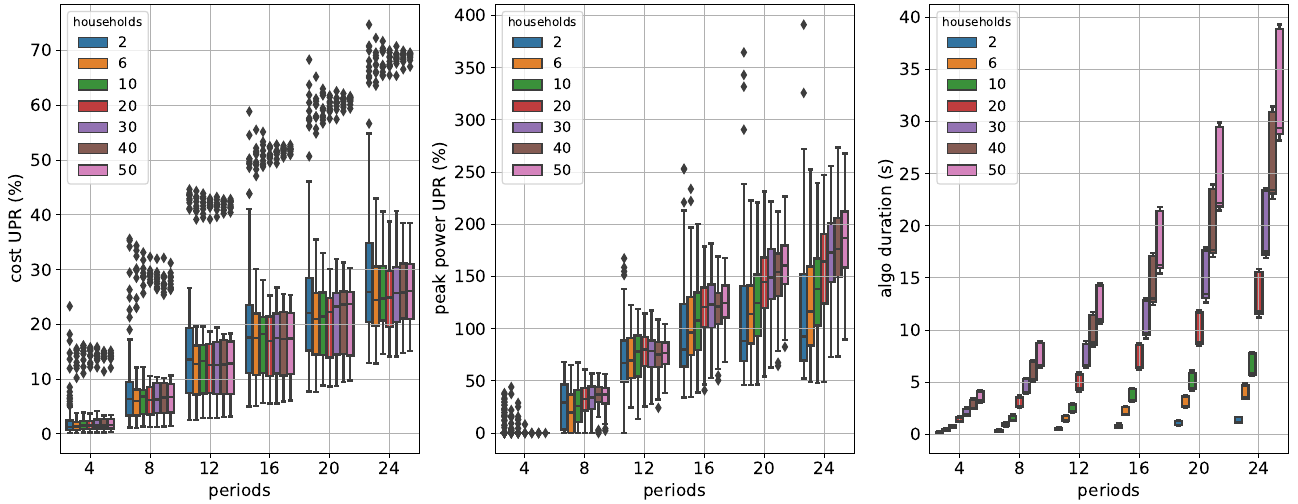
Figure 8. Spread of the quality measures cost UPR, peak power UPR, and algo duration for algorithm Cuboid Homothets Stage 1 using boxplots ordered by households from left 2 to right 50.